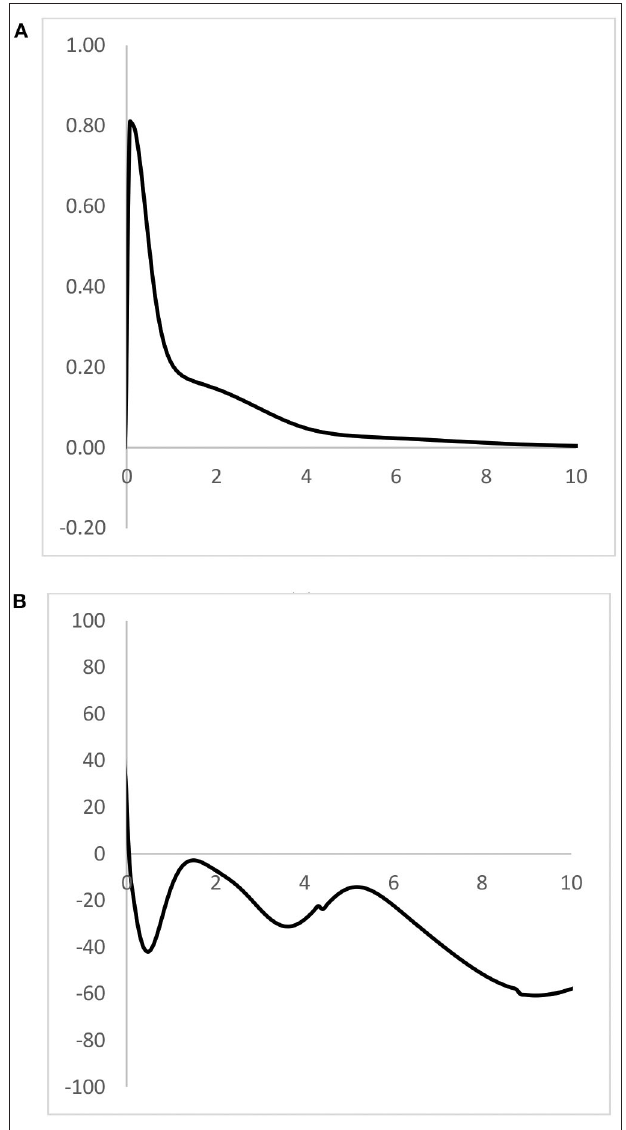
FIGURE 5 | Ergodic distribution and MPP of the oil market for all countries. Note: For (A) , horizontal axis represents relative per capita consumption, vertical axis represents proportion. For (B) , horizontal axis represents relative per capita consumption, vertical axis represents MPP. Source: Authors’